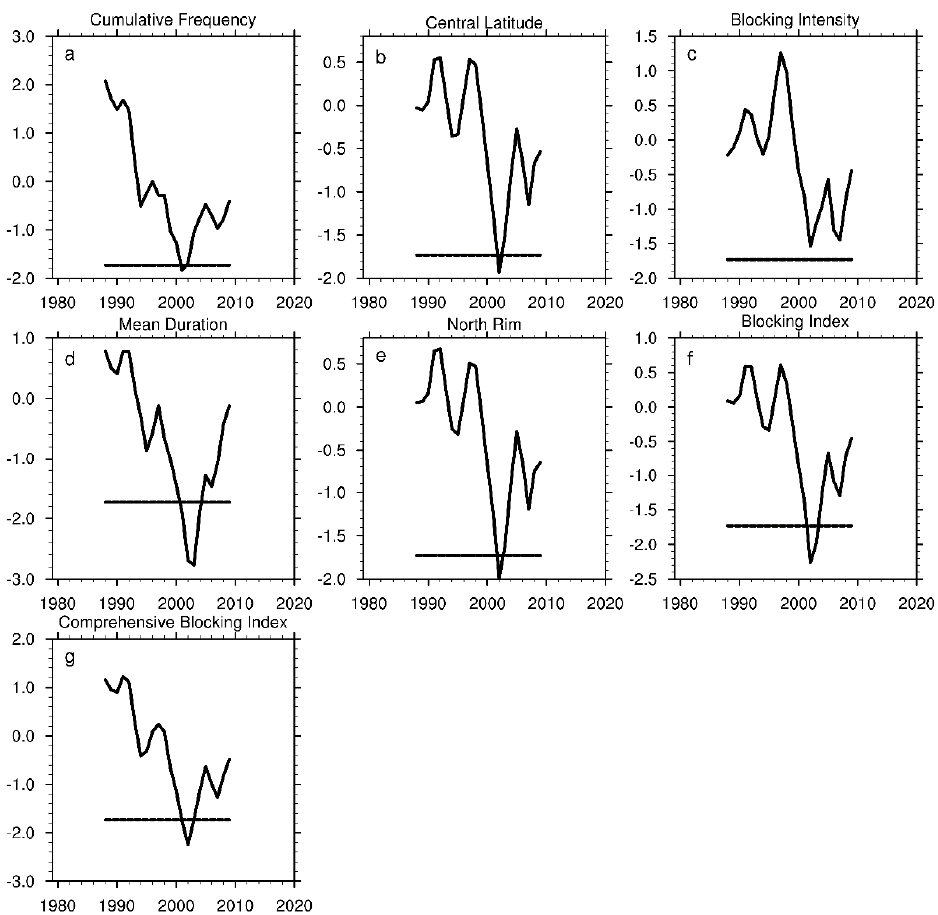
Figure 2. The moving t -test for each blocking index of the UB in winter over the period of 1979–2019. (Normalized: Fq ( a ), CL ( b ), BI ( c ), DU ( d ), NR ( e ), blocking index ( f ), comprehensive blocking index ( g ). The black lines represent the significance test of 95%).